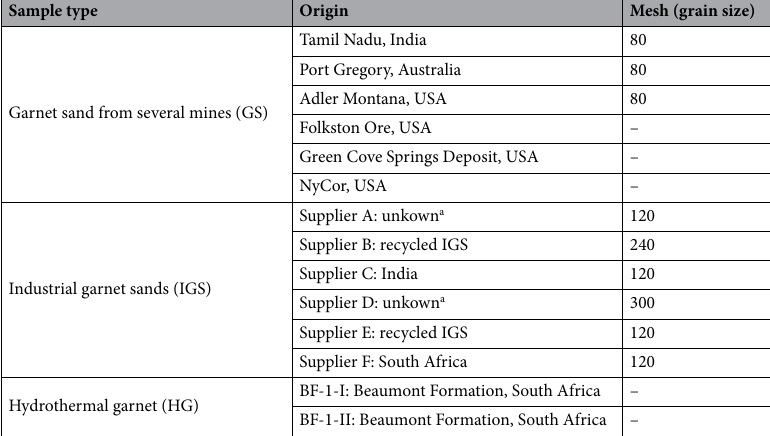
those of Sc and the REY) are in good agreement (RSD < 10% for most elements) with the data from the original analyses (Supplementary Table S3). Combined with the good agreement between our data for the BHVO-2 standard and its reference values, this strongly suggests that the differences between different aliquots of a garnet sand sample do not represent analytical artifacts but represent the natural inhomogeneity of the garnet sands. Reporting. The REY distribution is illustrated by chondrite-normalized REY patterns (subscript “CN”; chondrite data from Barrat et al. 57 and the Eu CN anomalies are quantified following Bau and Dulski as (Eu/